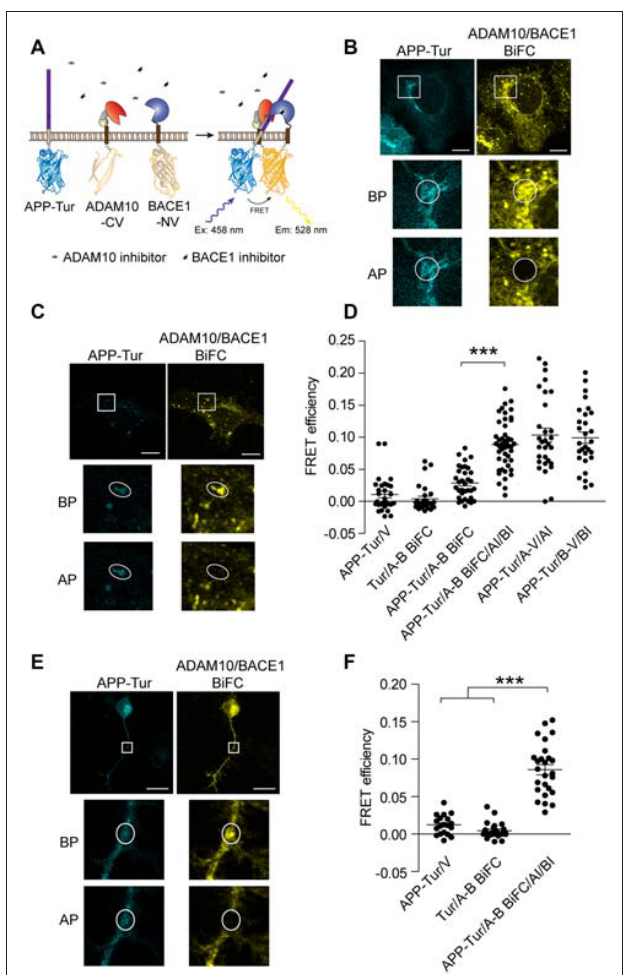
FIGURE 4 | Visualization of ternary complex of α -/ β -secretase with γ -secretase using BiFC-FRET. (A) Schematic for ADAM10-CV, BACE1-NV and mTurquoise2-PS1 (Tur-PS1) constructs. mTurquoise2 were fused to the N-terminal of PS1. (B,C) Representative images of PS1/ADAM10/BACE1 BiFC-FRET in (D) . Scale bar: 10 µ m. HEK 293 cells were transfected with ADAM10-CV/BACE1-NV/Tur-PS1 (B) or ADAM10-CV/BACE1-NV/ Tur-PS1/ Aph1aL (A)/Nct (N)/Pen2 (P); (C) for 16 h and fixed for FRET analysis. (D) FRET analysis of α -/ β -/ γ -secretase ternary complex. HEK 293 cells were transfected with designated plasmids for 16 h, and fixed for FRET analysis. N = 34–46 per condition. A one-way ANOVA with Bonferroni’s multiple comparisons was used. ∗∗∗ p < 0.001. (E) Secretases inhibitors do not affect α -/ β -/ γ -secretase BiFC-FRET. HEK 293 cells were transfected with ADAM10-CV/BACE1-NV/Tur-PS1/A/N/P for 8 h and treated with 3 µ M α -secretase inhibitor GI254023X (AI) or 1 µ M β -secretase inhibitor BSI-IV (BI) or 1 µ M γ -secretase inhibitor L685, 458 (GI) for another 8 h. N = 33–36 per condition. A one-way ANOVA with Bonferroni’s multiple comparisons was used. (F) APP α -/ β - cleavage sites mutant enhanced α -/ β -/ γ -secretase BiFC-FRET. HEK 293 cells were transfected with ADAM10-CV/BACE1-NV/Tur-PS1/A/N/P and designated plasmids for 16 h, and fixed for FRET analysis. N = 27–36 per condition. A one-way ANOVA with Bonferroni’s multiple comparisons was used. ∗ p <